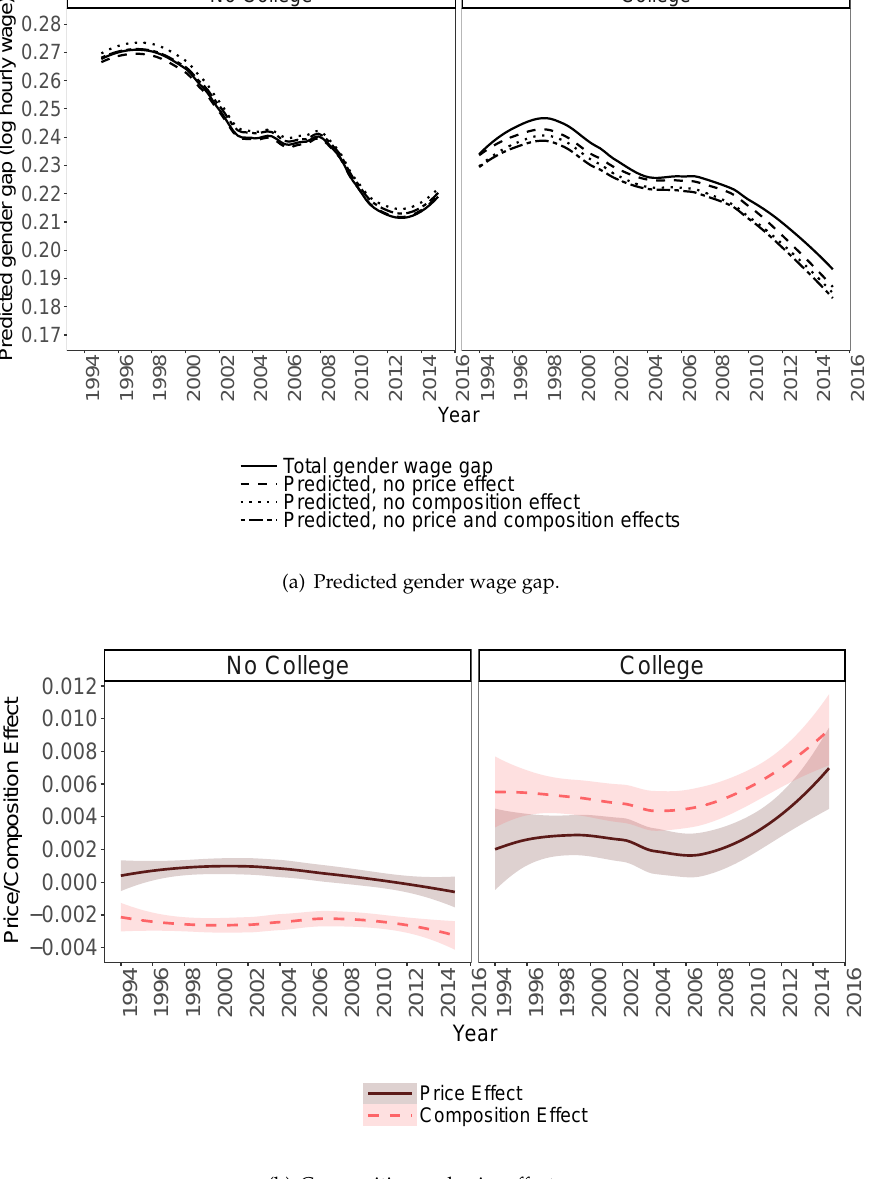
(b) Composition and price effects. Figure 4: Counterfactual simulation results for composition and price effects of programming intensity on the gender wage gap. See Table 2 for the data source. All curves are Loess smoothed with a span 0.5. Alternative span widths yield similar